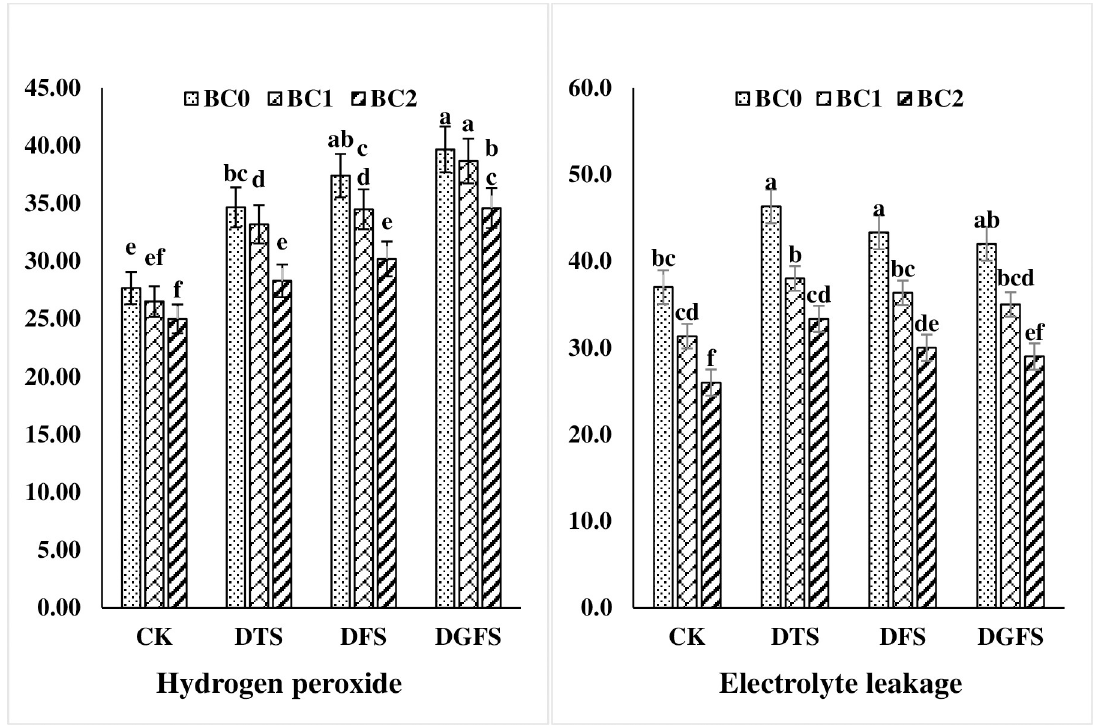
Fig 4. Hydrogen peroxide ( μ M g -1 FW) and Electrolyte leakage (%) affected by biochar application under drought stress at critical growth stages of wheat. CK, DTS, DFS and DGFS indicates control, drought at tillering, flowering and grain filling stages respectively. BC 0 , BC 1 and BC 2 indicates control, 3% and 5% biochar respectively. Error bars indicates standard error (n = 4).